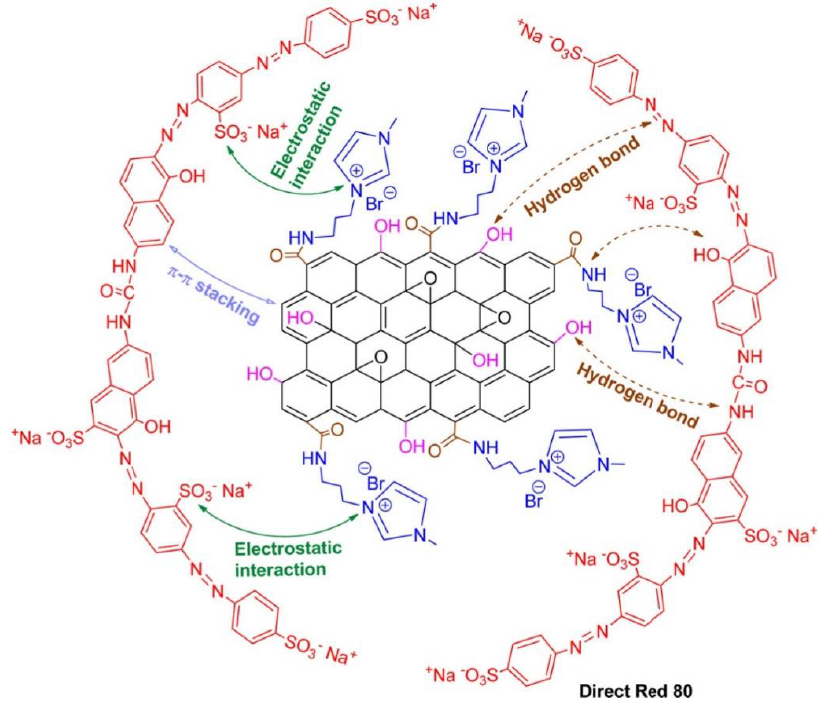
Figure 4. Adsorption of dyes over carbon-based materials via different interactions. Reprinted from ref. [34] with permission.